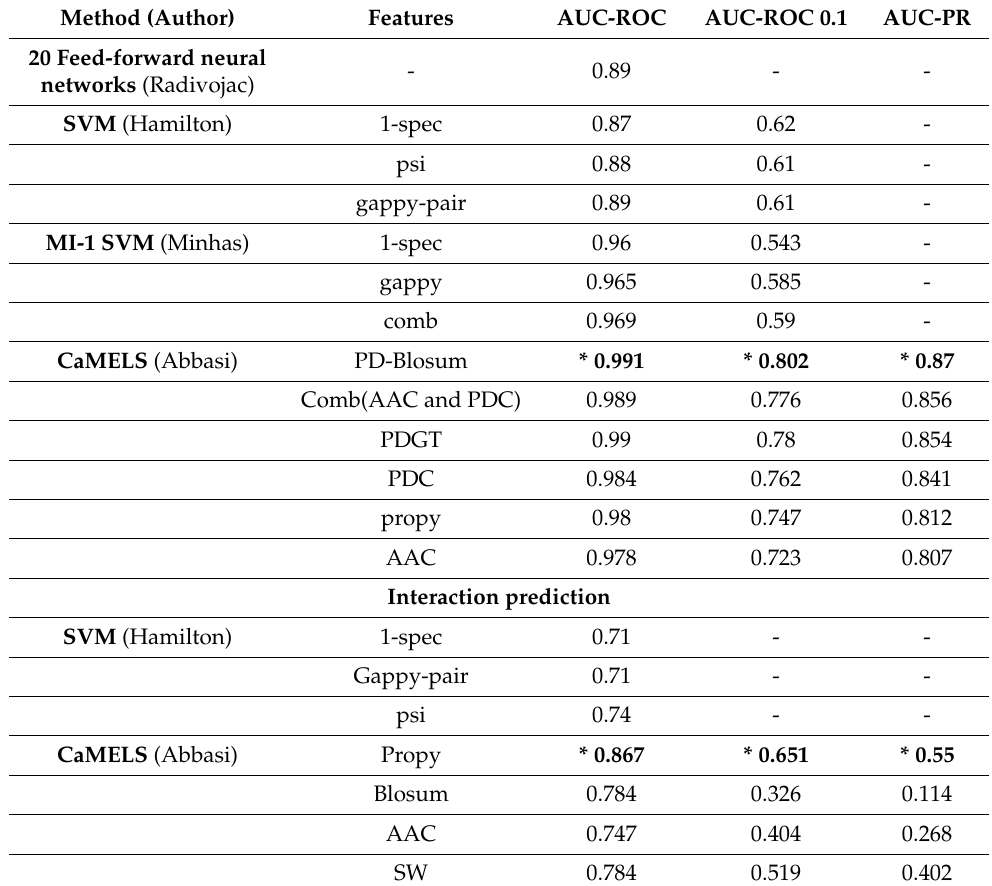
Table 4. Comparison of CaM-Binding Site Prediction